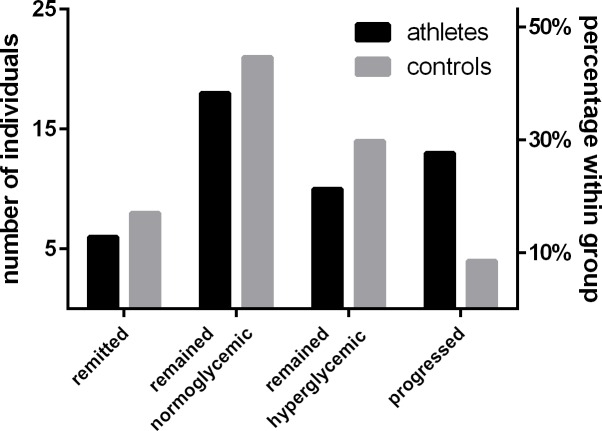
Glykemic state and physical activity.Descriptive depiction of the development of glycaemia during a three years follow up period.